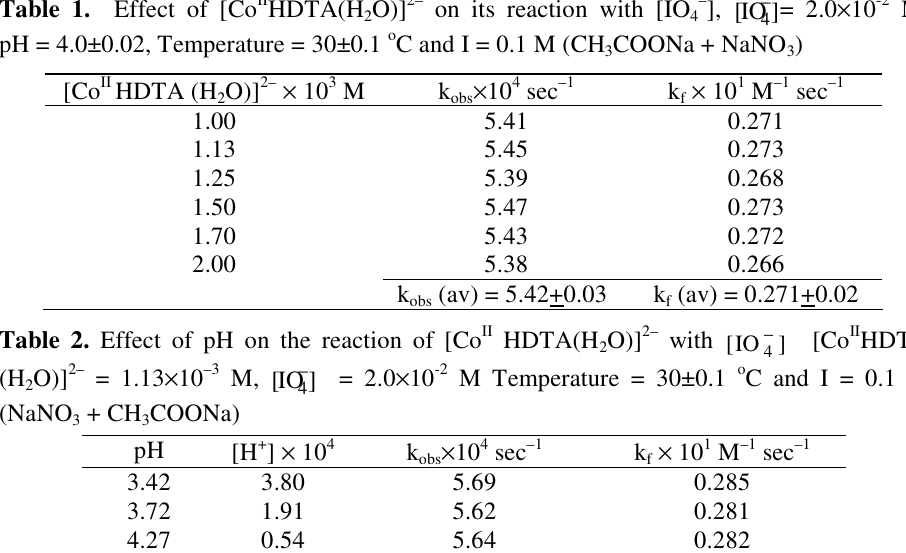
O)] 2– on its reaction with [IO 4– ], ]IO[ 2